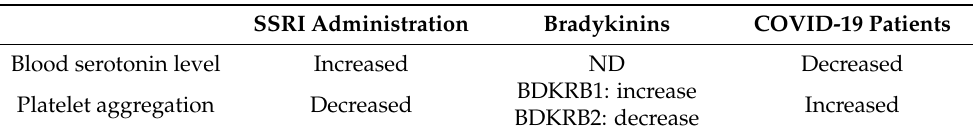
Table 2. Reported effects on blood serotonin levels and platelet aggregation of selective serotonin- reuptake inhibitor antidepressant administration in comparison to those induced by bradykinins, observed in COVID-19 patients